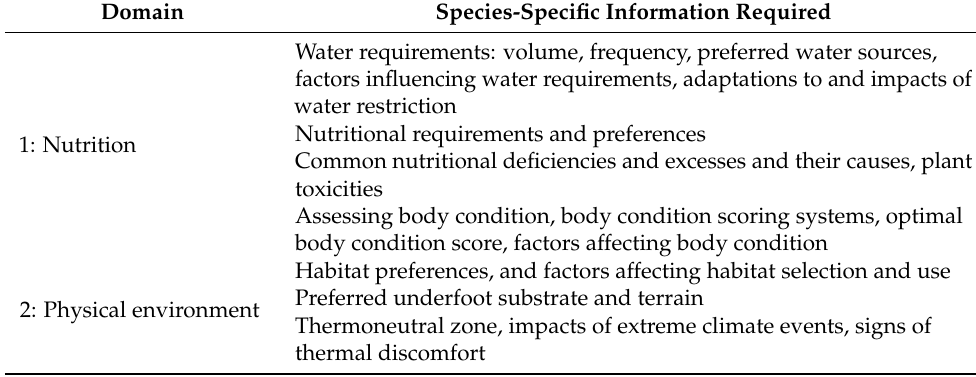
Table 2. Illustration of the species-specific information required to assess welfare of free-roaming horses using the Five Domains Model (from Harvey et al., 2020